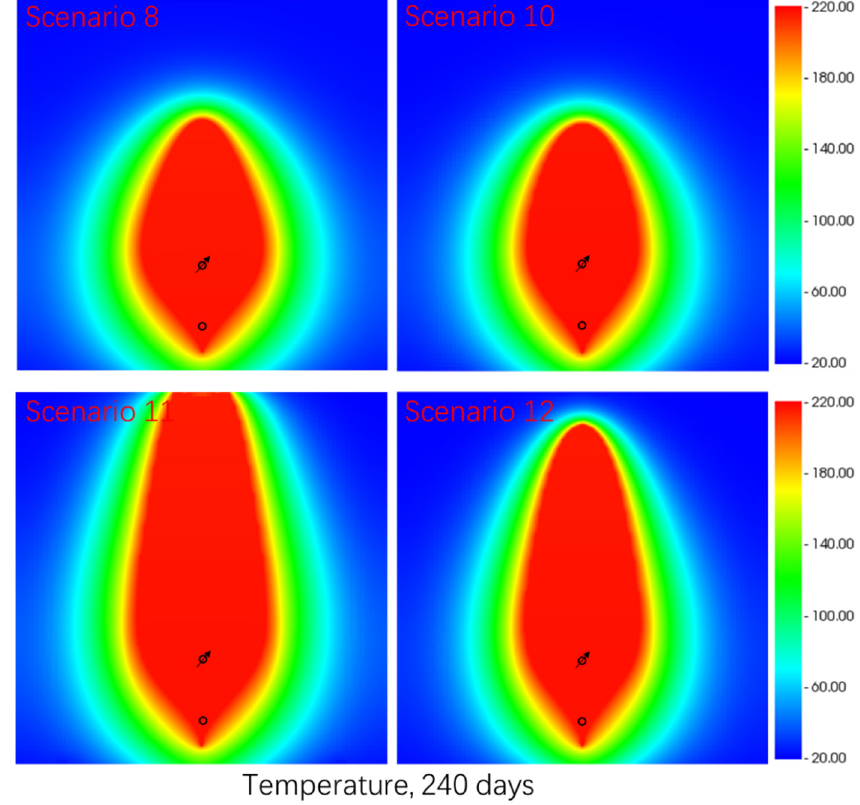
Figure 12. Cross-sectional temperature distributions of scenarios 8, 10, 11 and 12 under varying relative permeability settings.